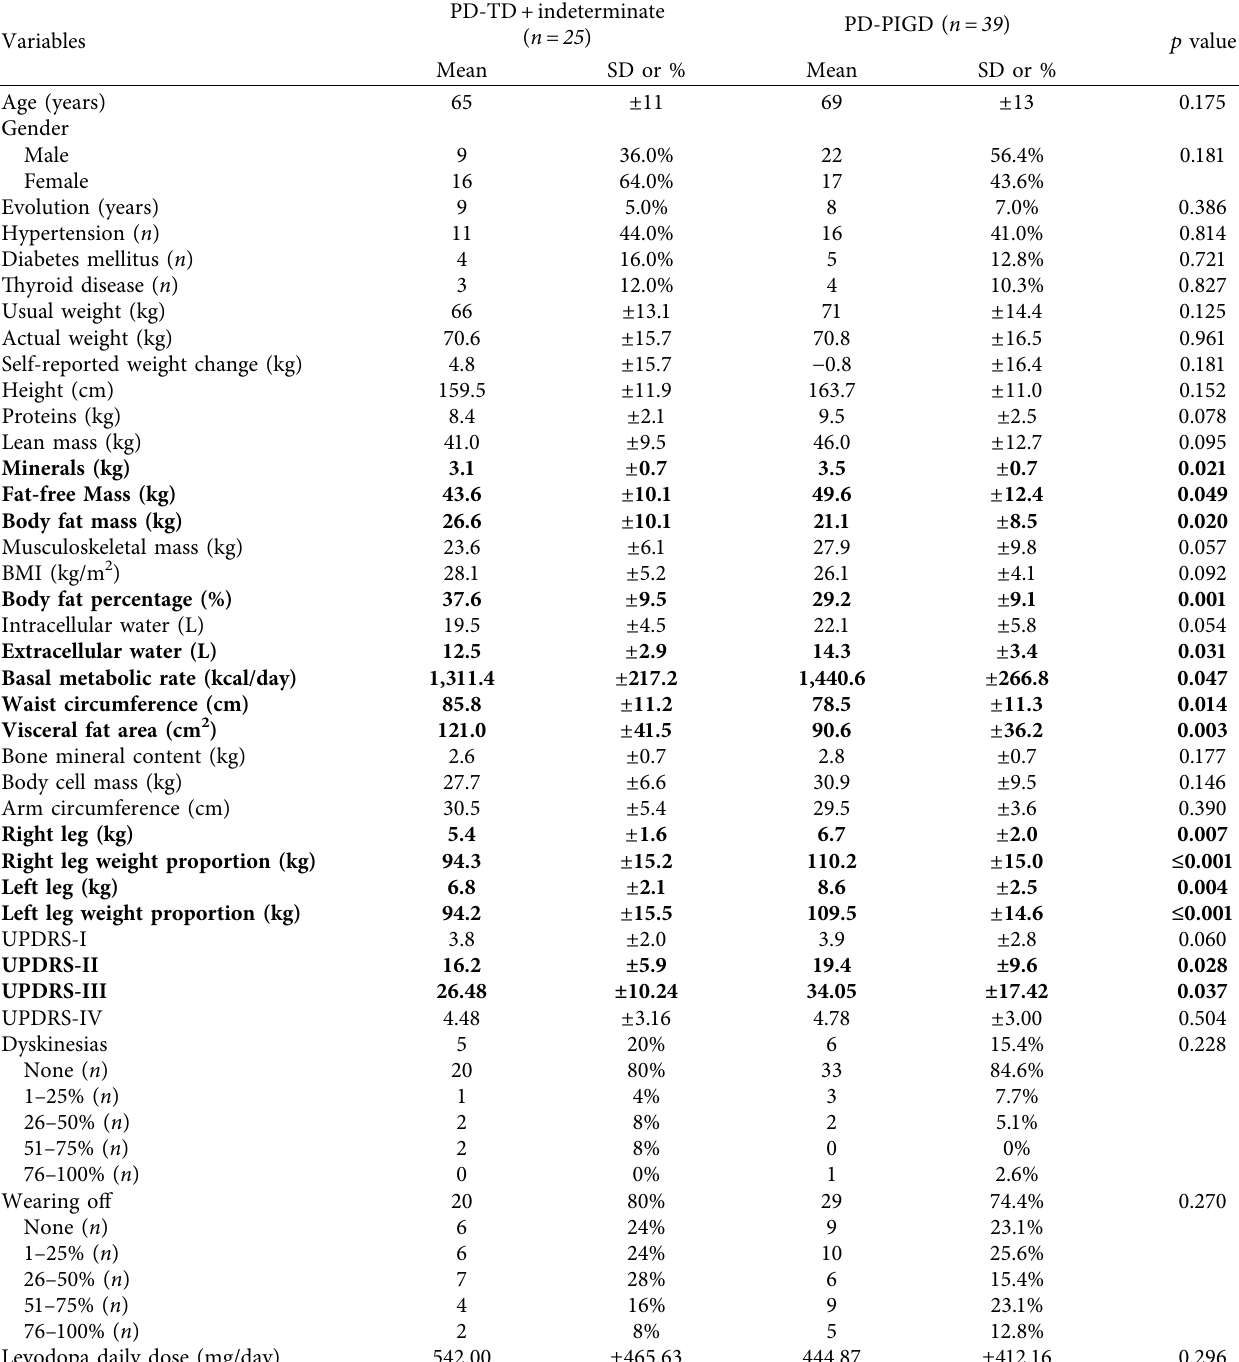
Table 2: Demographic and BIA parameters of PD-T+ indeterminate and PD-PIGD